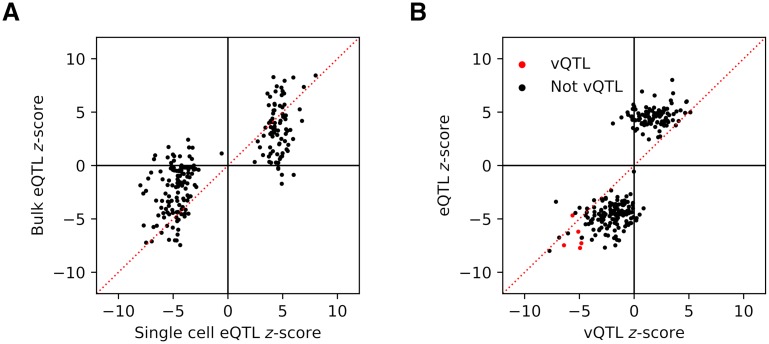
Discovery and overlap of expression QTLs and variance QTLs.(A) z-scores for expression QTL (eQTL) SNP-gene pairs discovered in pooled single cell RNA-seq data against z-scores of the same SNP-gene pairs in matched bulk RNA-seq data. (B) In the single cell data, z-scores for eQTL SNP-gene pairs (FDR 10%) against variance QTL (vQTL) z-scores of the same SNP-gene pairs. vQTL z-scores are stratified based on whether the gene was discovered as a vQTL at FDR 10%.